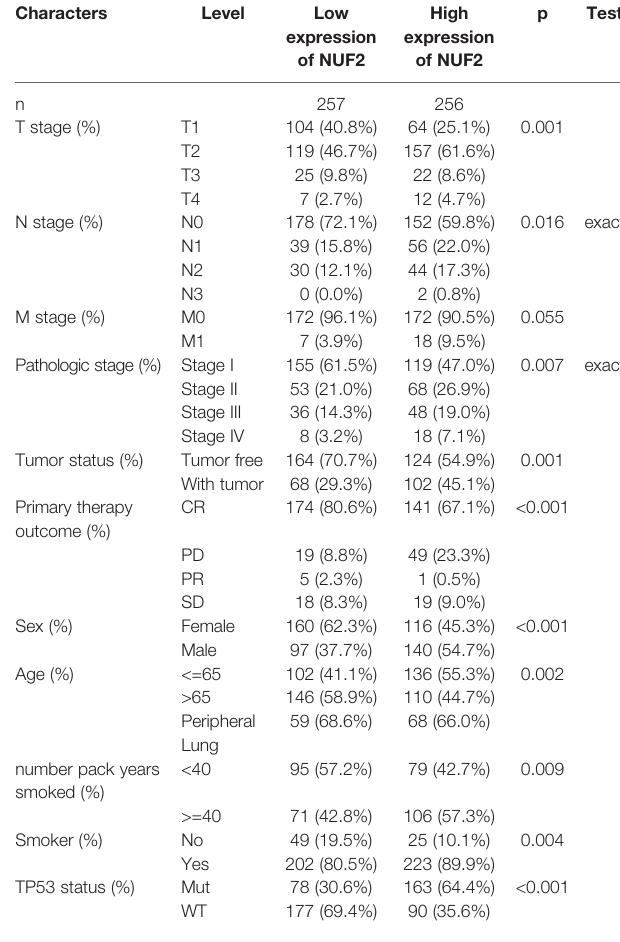
TABLE 1 | Relationship between NUF2 expression and clinicopathological parameters in our cohort. Characteristic Low expression of NUF2 High expression of NUF2 p